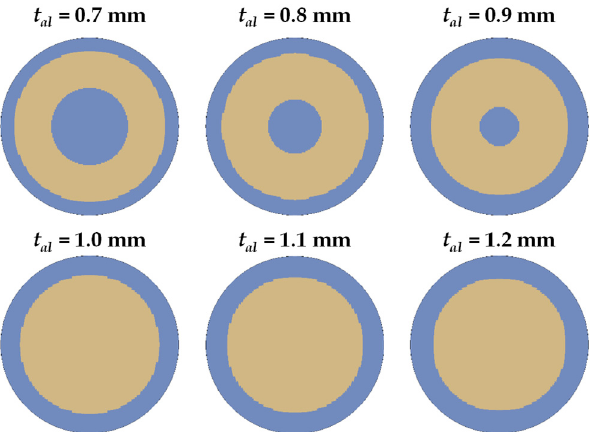
Figure 11. Predicted stripping patterns for different values of aluminum thickness. Epoxy’s thickness is 25 μ m, spot diameter is 4 mm and P max = 2639 MPa. t al = 0.7 mm t al = 1.2 mm